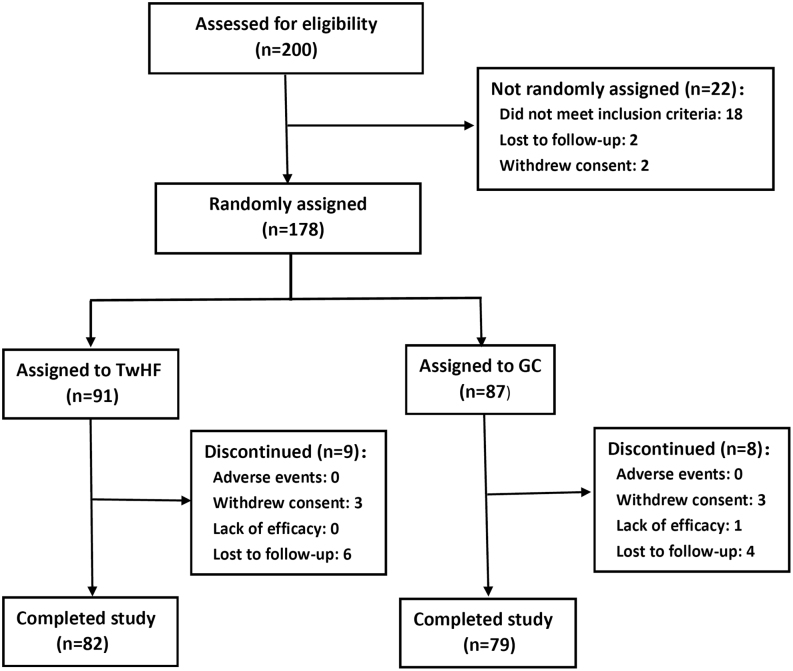
Study flow diagram. TG, Tripterygium glycosides; iv.MP, intravenous methylprednisolone.